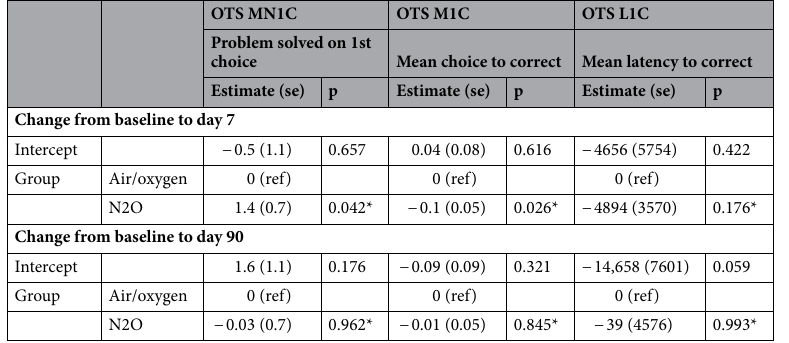
Table 6. Adjusted Group differences for outcome measures of the OTS. *Adjusted for sevoflurane (concentration per unit) and duration of surgery (per hour) in multiple regression linear models. In addition, a modification of the effect from day 7 to day 90 was tested with an interaction term in a linear regression model with mixed effects and was not found statistically significant (p-values from 0.12 to 0.45).